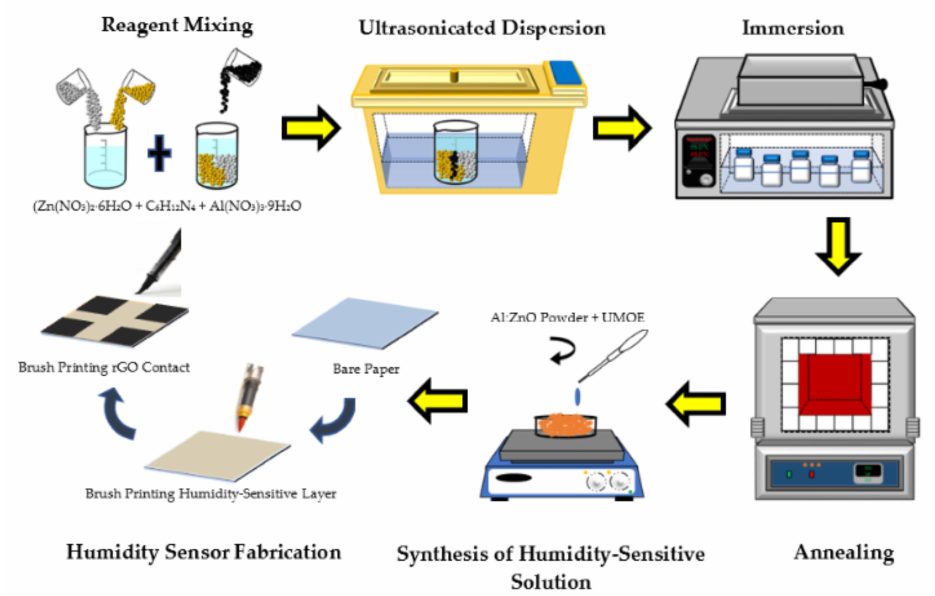
Figure 1. Schematic diagram of Al:ZnO-based humidity sensor preparation